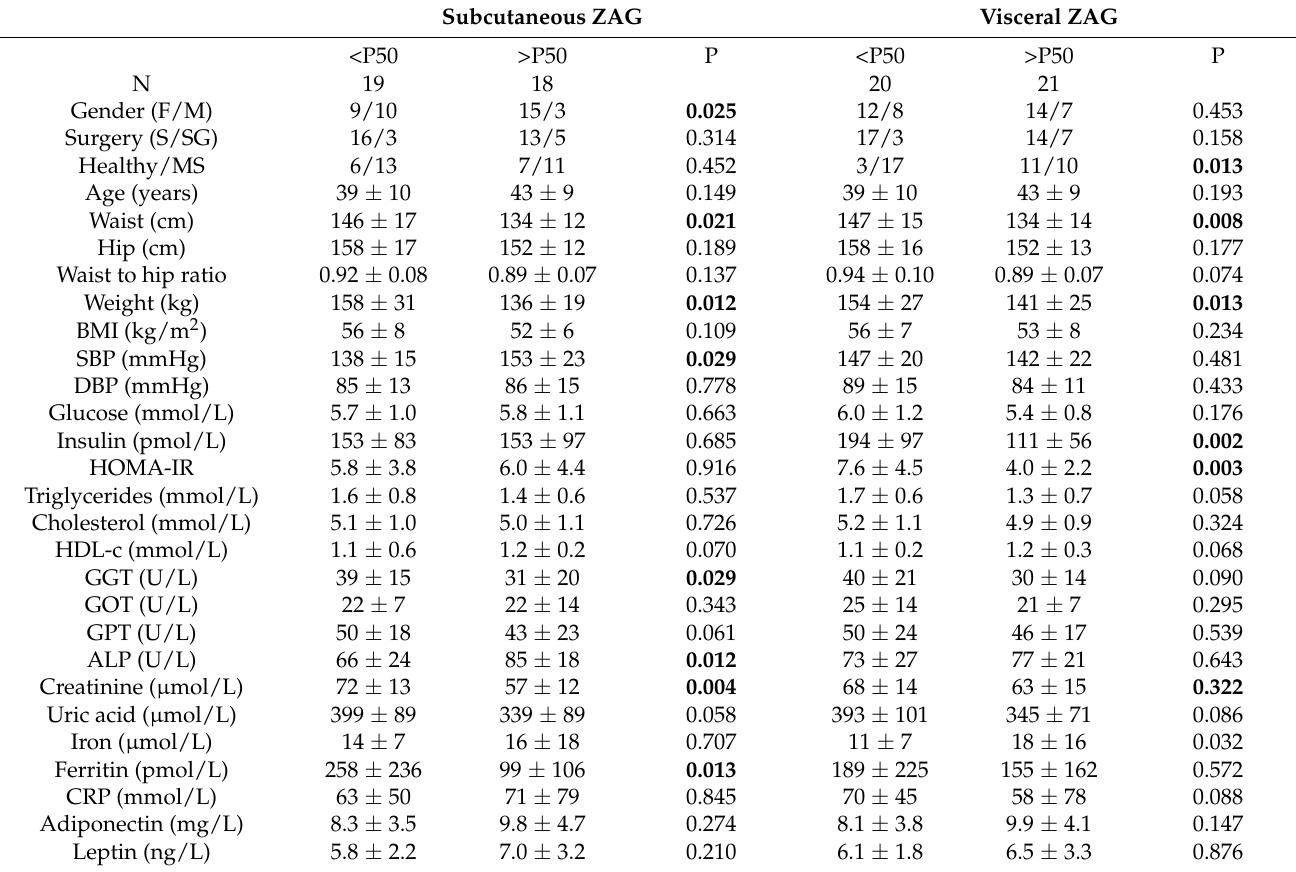
Table 1. Clinical and biochemical characteristics of studied patients with class III obesity before bariatric surgery (basal) classified by the 50th percentile of SAT and VAT ZAG gene expression. Subcutaneous ZAG Visceral ZAG <P50 >P50 P <P50